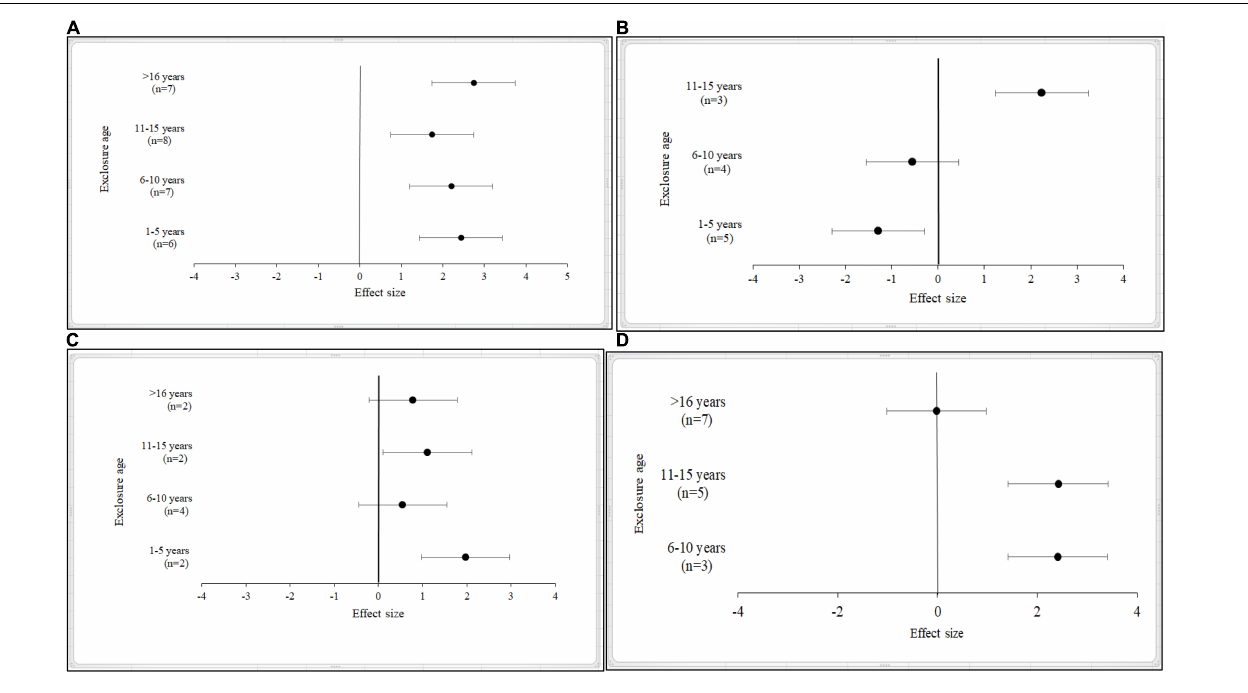
FIGURE 6 | Changes in soil organic carbon following establishment of exclosures on communal grazing lands in Ethiopia: (A) dry Dega, (B) moist Weynadega, (C) dry Weynadega, and (D) dry Kolla Agroecologies. See Figure 5 for further details.